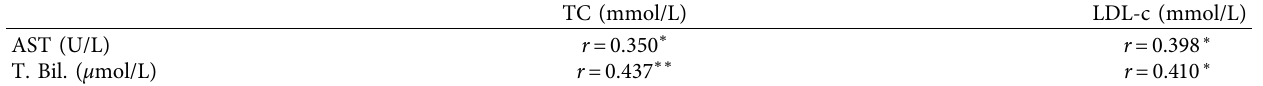
Table 3: Correlation ( r ) between serum liver parameters and lipid profile at week 12.